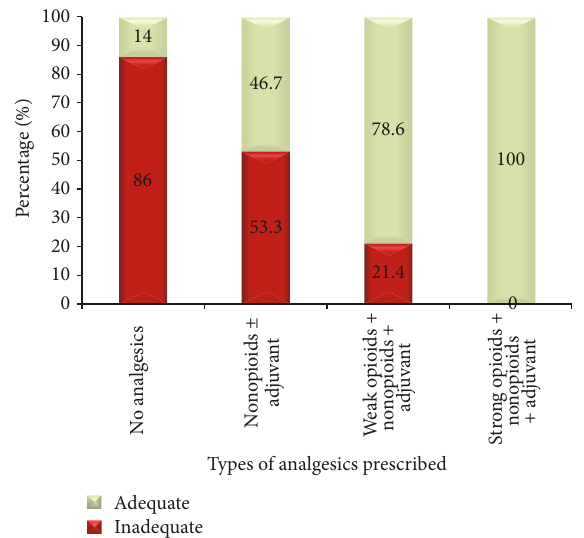
Figure 3: Percentage of cancer pain management adequacy within types of analgesics prescribed, Gondar University Hospital, Gondar, Ethiopia.